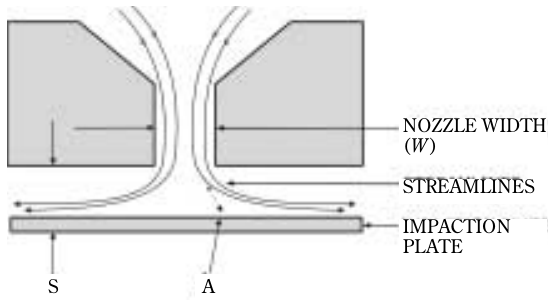
Schematic of a single stage impactor, showing divergent streamlines in flow approaching collection surface, with particle trajectory meeting surface at point